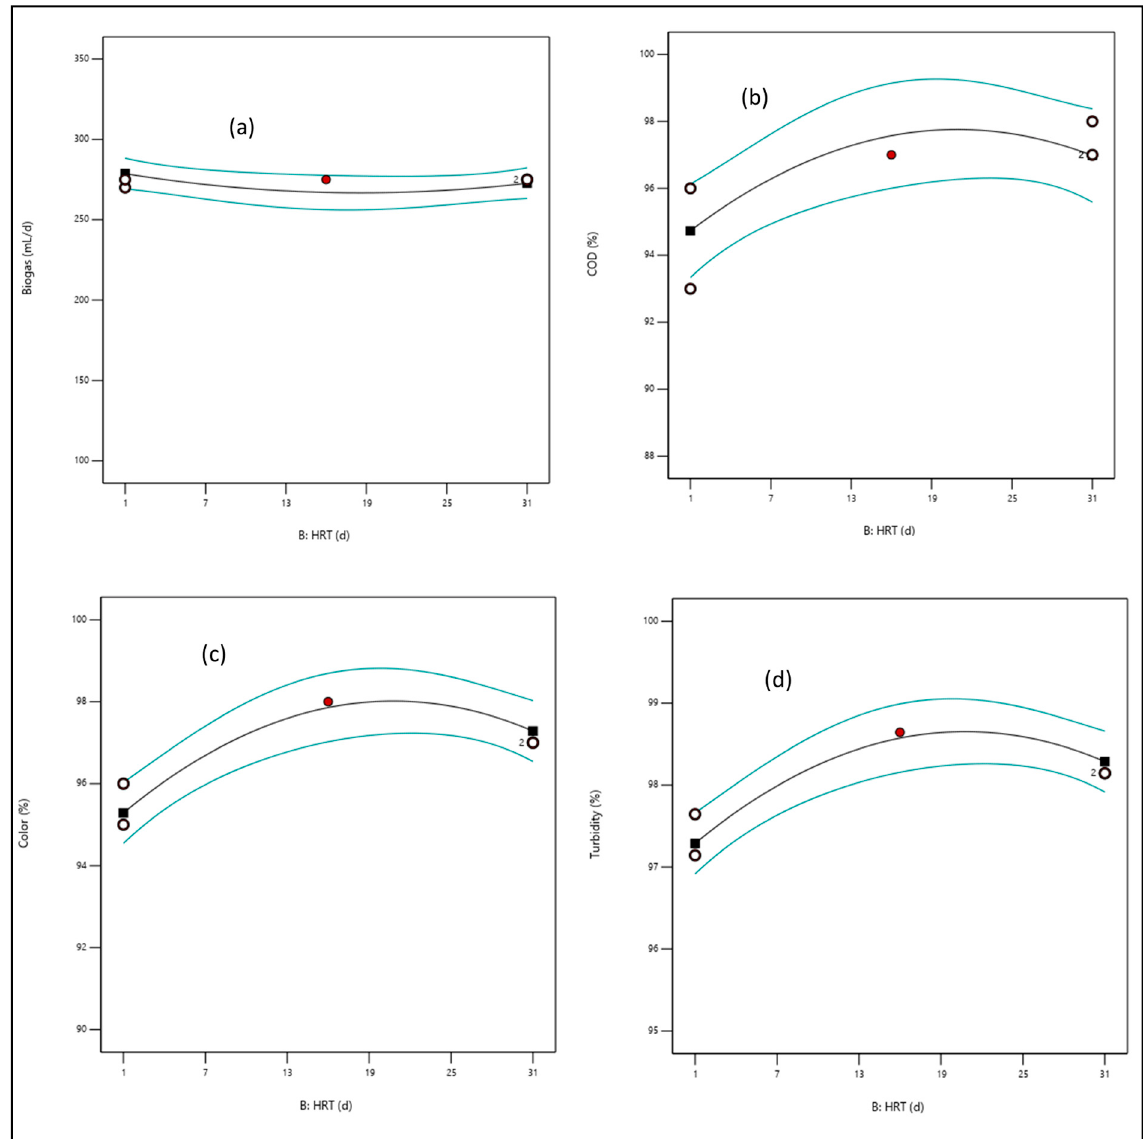
Figure 7. A diagnostic plot of the effect of HRT (1–31 d) on ( a ) biogas, ( b ) COD, ( c ) color, and ( d ) turbidity. The blue lines are the threshold or region of the response. The black is the trend line of the response. The whites and black circles are the level points of the response, whereas the red shows the high levels